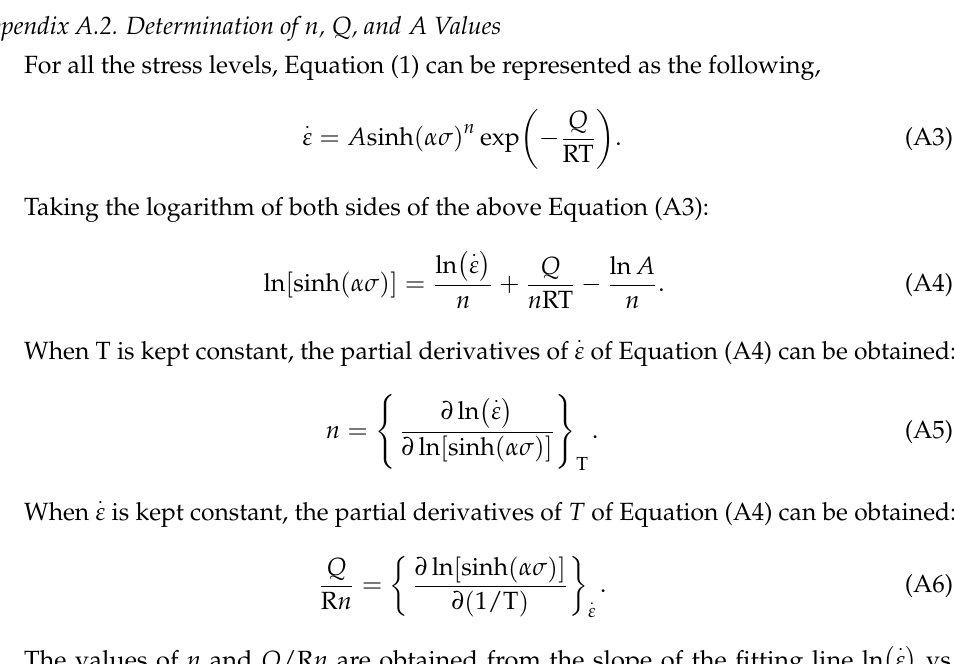
Figure A1. Fitting line ( a ) 𝛽 by plotting ln(𝜀(cid:4662)) vs. 𝜎 ; ( b ) 𝑛 (cid:2869) by plotting ln(𝜀(cid:4662)) vs. ln (𝜎) .